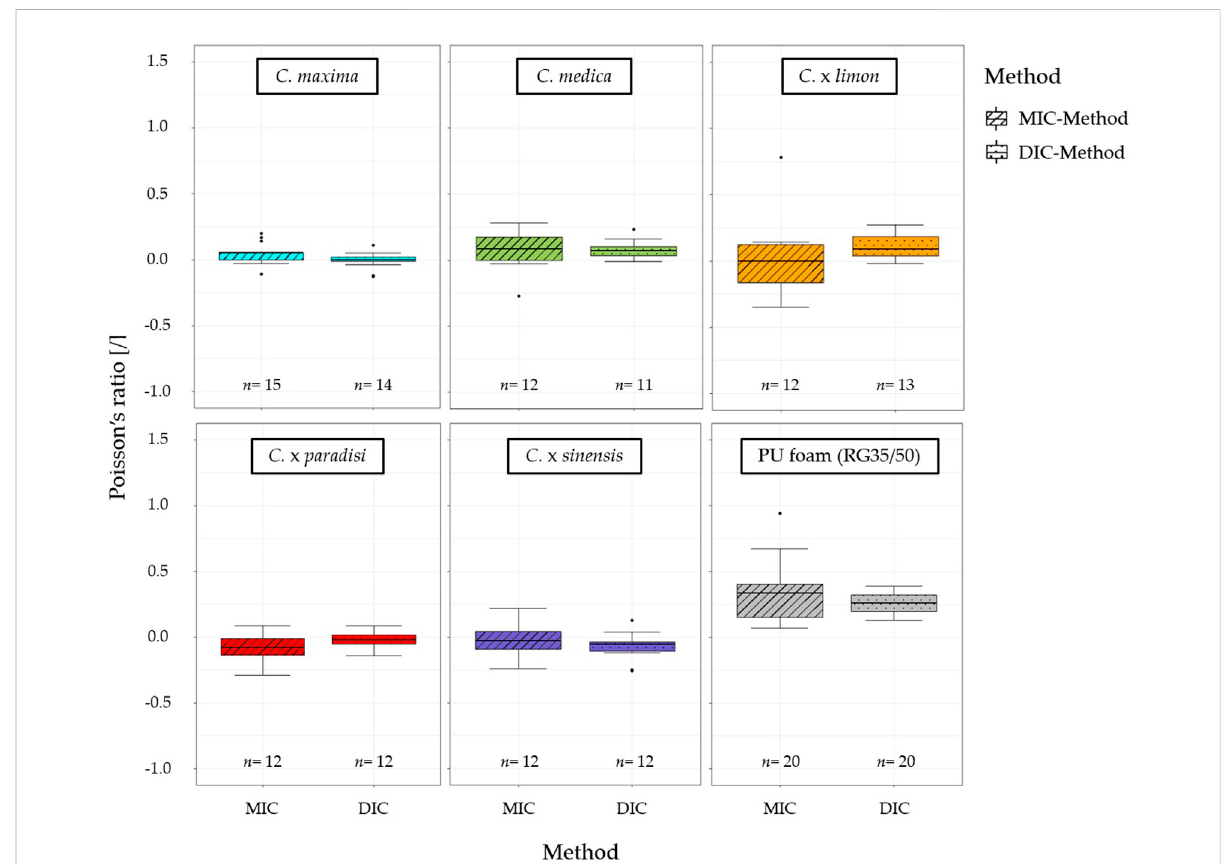
FIGURE 8 Comparison of the Poisson ’ s ratios of the tested citrus species: pomelo ( C. maxima ), citron ( C. medica ), lemon ( C. x limon ), grapefruit ( C. x paradisi ), orange ( C. x sinensis ), and for the PU foam (RG35/50) calculated using the manual image correlation method (MIC) and the digital image correlation method (DIC). No signi fi cant differences between DIC and MIC occur for all tested